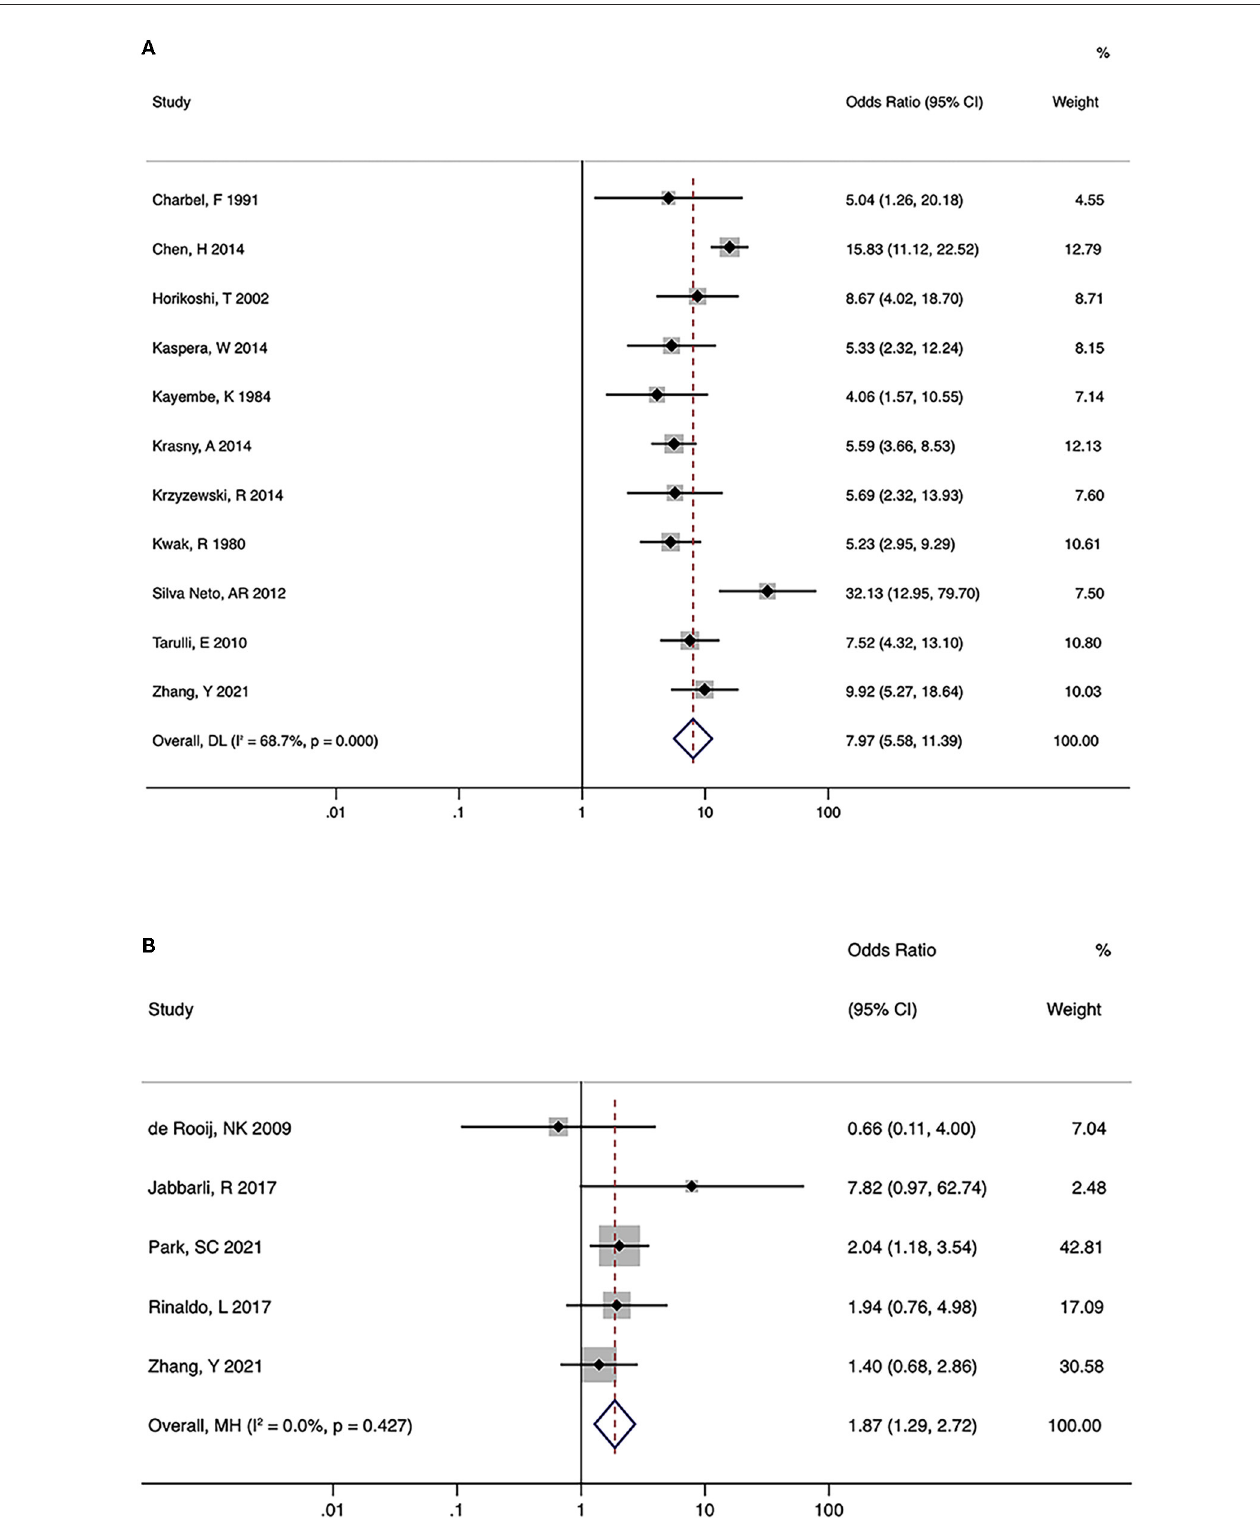
FIGURE2 Summary odds ratios of hypoplastic/aplastic A1 and anterior communicating artery (AcomA) aneurysms. (A) AcomA aneurysms vs. healthy controls (B) ruptured vs. unruptured AcomA